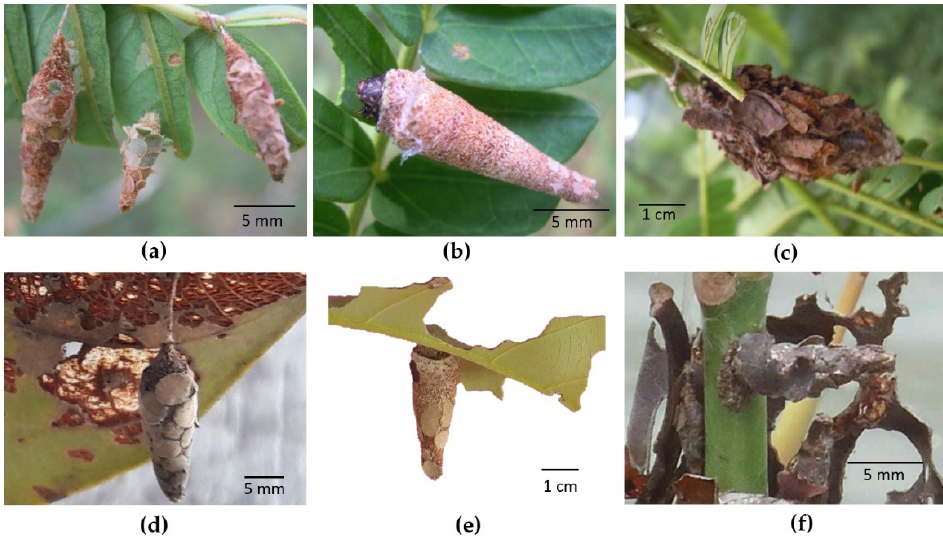
Figure 3. Some common bagworm species associated with Indonesian forest trees. Larvae are equipped with a bag as a morphologically unique feature: ( a ) Falcataria moluccana infested by Pteroma plagiophleps ; ( b ) Falcataria moluccana infested by Amatissa sp.; ( c ) Falcataria moluccana infested by Cryptothelea sp.; ( d ) Shorea balangeran infested by Pteroma sp.; ( e ) Shorea balangeran infested by Cryptothelea sp.; ( f ) Mangrove infested by Pagodiella sp.